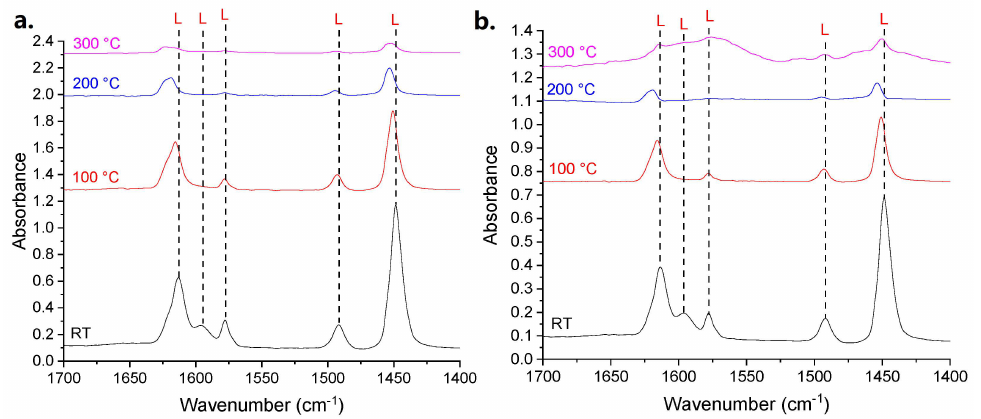
Figure 7. FT-IR spectra of pyridine adsorbed on Al 2 O 3 _A_900 ( a ) and Al 2 O 3 _B_900 ( b ) acquired after degassing at 25, 100, 200, and 300 ◦ C.